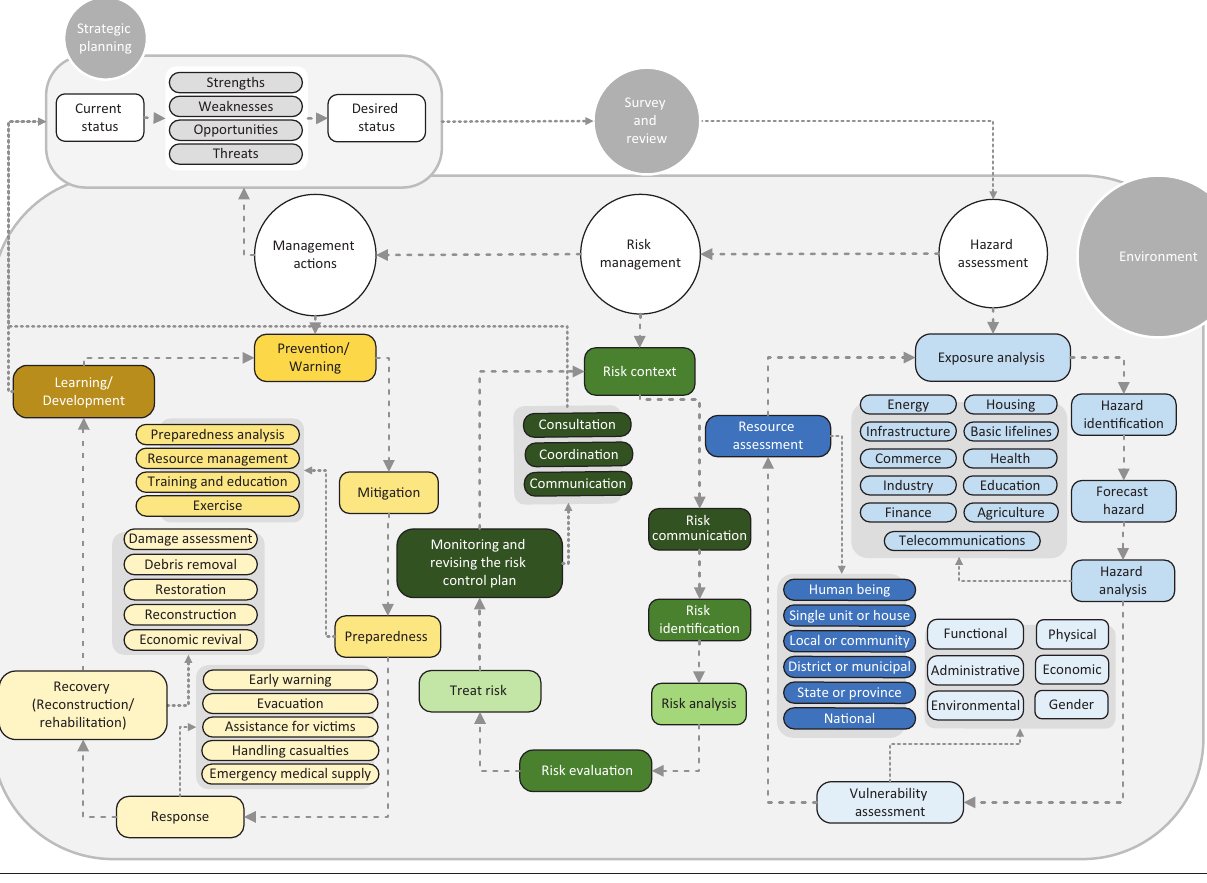
FIGURE 3: Comprehensive conceptual model of disaster